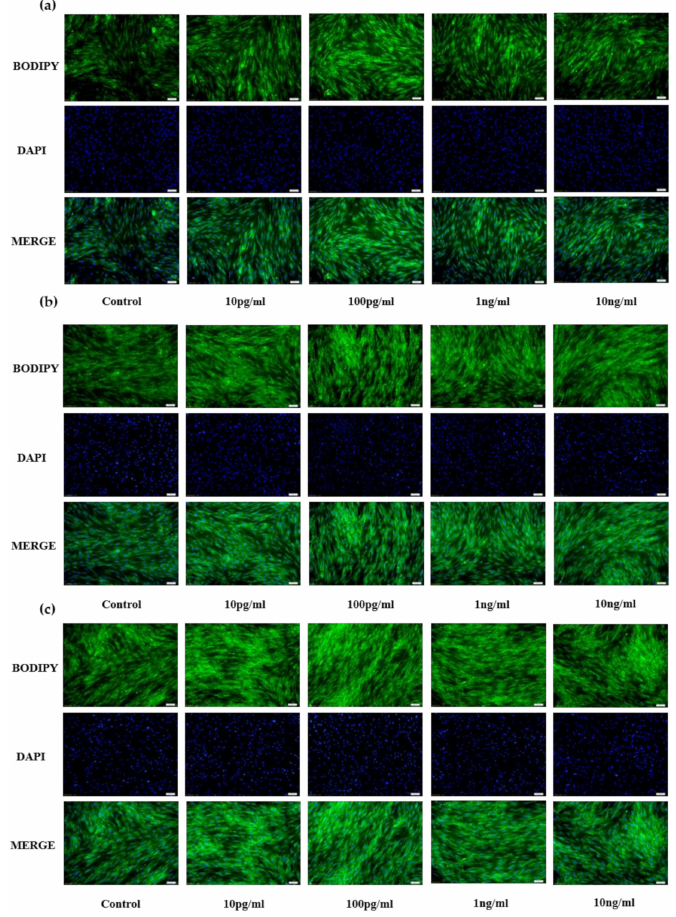
Figure 1. Effects of NENF with different concentrations of preadipocyte differentiation. ( a ) Bovine adipocytes are stained with BODIPY (green) and DAPI (blue) after adding the recombinant protein NENF and PBS at 2nd day of natural differentiation (D2); ( b ) 4th day of natural differentiation (D4); ( c ) 6th day of natural differentiation (D6). (OLYMPUS IX71 100 ×